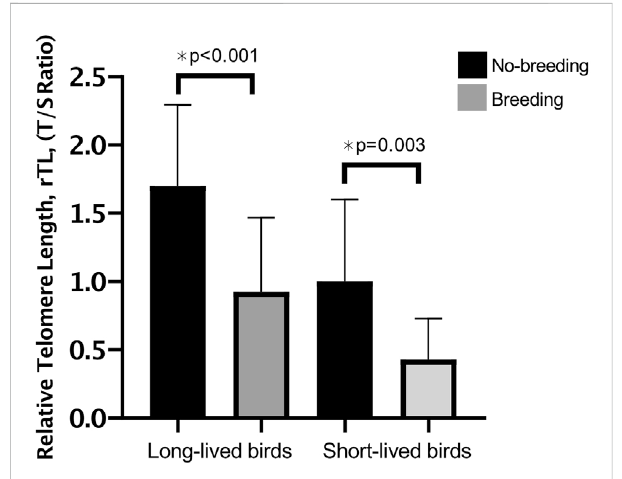
FIGURE 3 Relative telomere length (rTL) in long- and short-lived birds with different breeding statuses. Mean rtL ±SD of breeding vs. non- breeding for long- and short-lived birds. A three-way ANOVA was conducted to determine the effects of sex, longevity and reproduction. No interactions were statistically signi fi cant. There was an effect of longevity and reproduction on rTL, however, the differences in rTL for male and female birds were not statistically signi fi